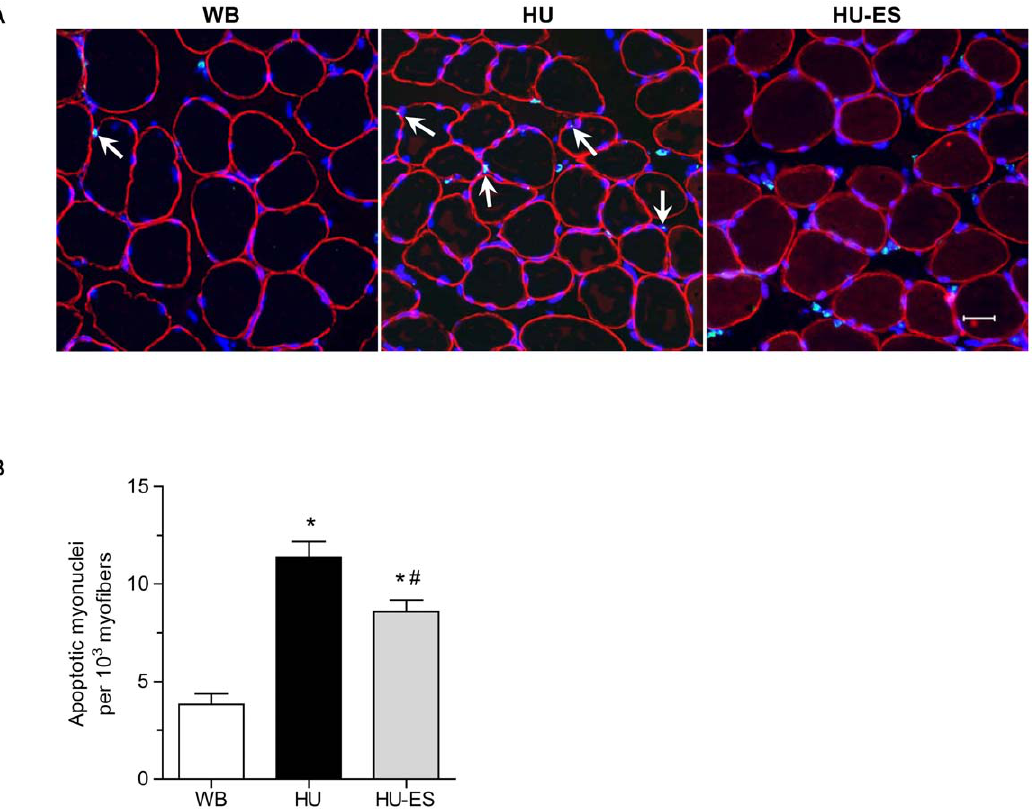
Figure 4. TUNEL analysis in soleus myofibers. (A) Representative images showing cross-sections of soleus muscle from weight-bearing (WB), hindlimb-unloaded (HU), and electrically stimulated (HU-ES) groups with TUNEL labeling (green, arrows) counterstained with DAPI (blue) for nuclei identification. Antibodies stained against dystrophin (red) for myofiber visualization. Scale bar=25 m m. (B) Apoptotic index is expressed as the number of apoptotic myonuclei per 10 3 myofibers. *p , 0.05, significant difference compared to WB group; # p , 0.05, significant difference compared to HU group. Values are means 6 SEM.